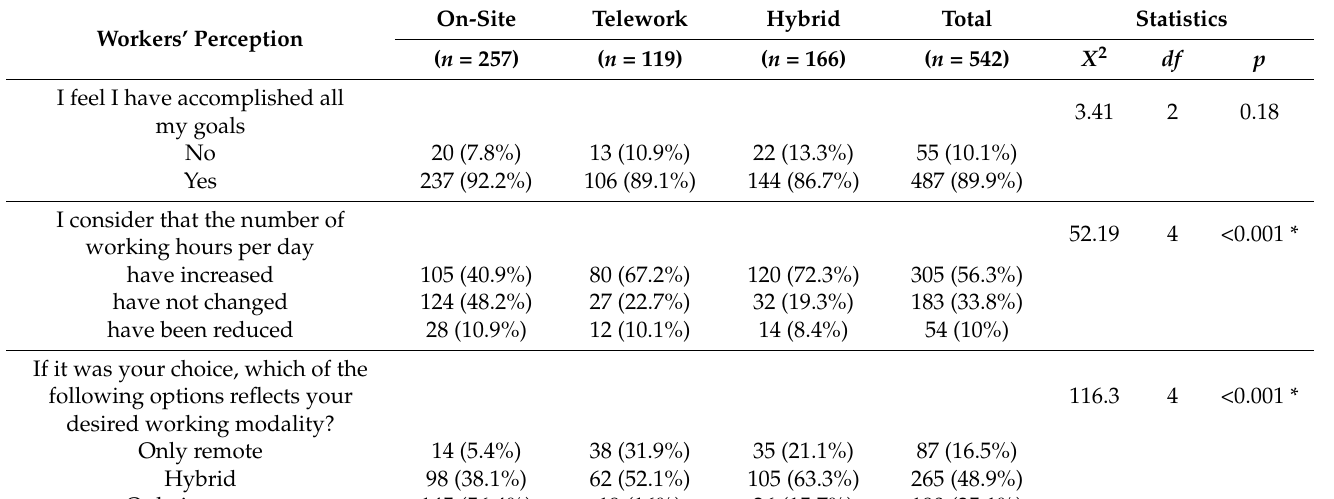
Table 3. Workers’ perceptions about their performance within their company by modality and comparison